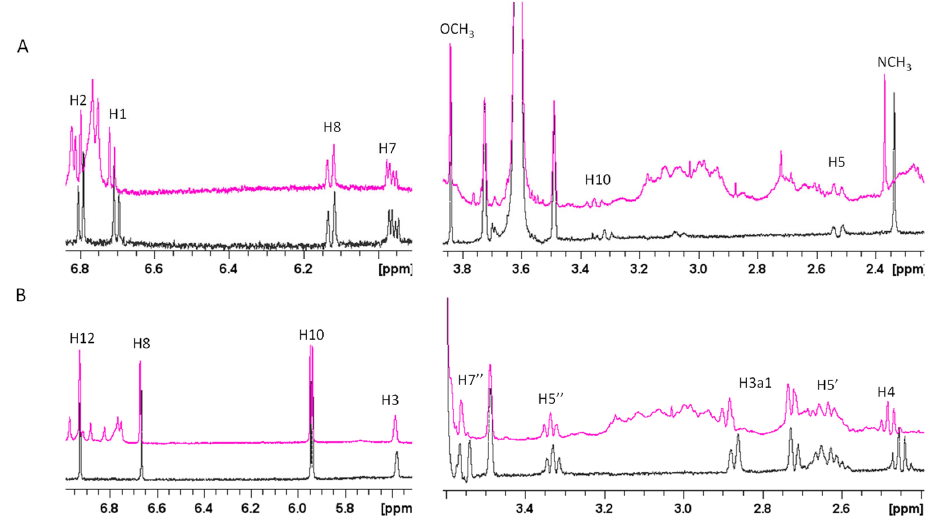
Figure 4. Selected regions of 1 H spectra of ( A ). GAL and ( B ). LYC in absence (black lines) and in presence of 1.2 eqs. of A β 40 (magenta lines). Alkaloid concentration 0.15 mM, A β 40 concentration 0.18 mM EtOD(60)/H 2 O(40) (phosphate buffer 20 mM) mixture, T = 298 K.